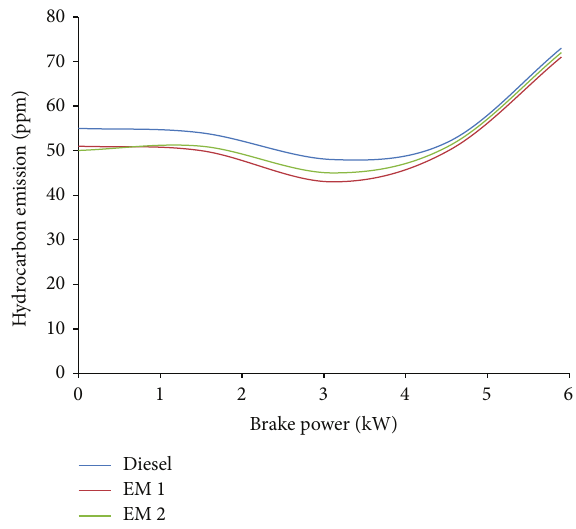
Figure 3: Brake power versus hydrocarbon (HC)